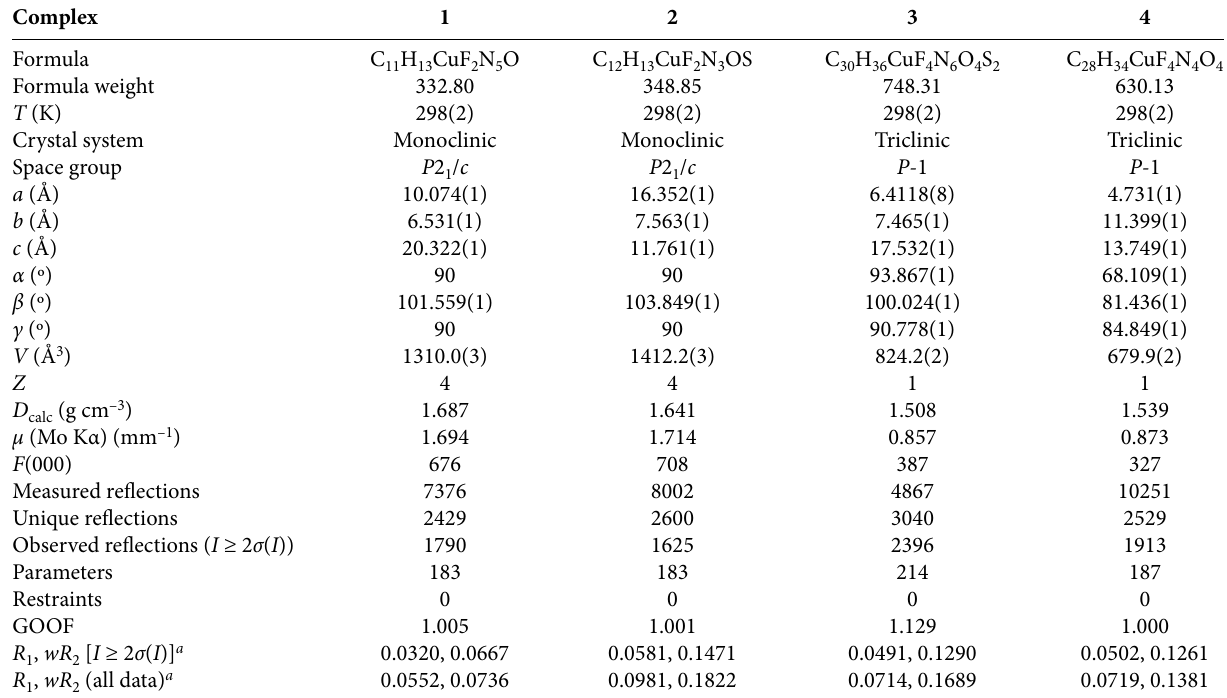
Table 1. Crystallographic and refinement data for the complexes